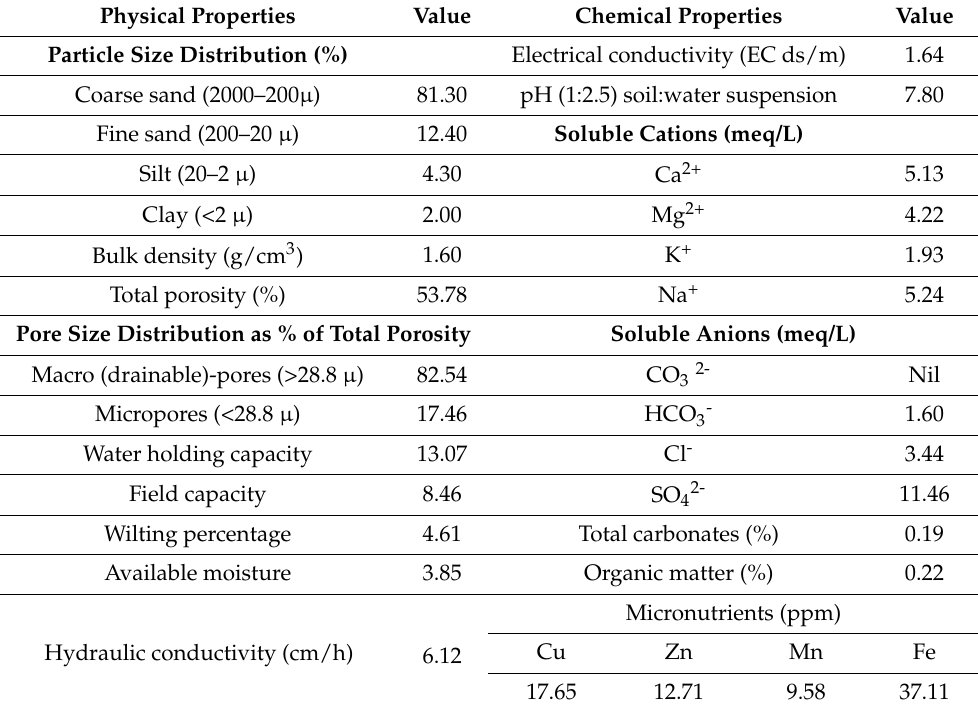
Table 3. Physical and chemical properties of experimental soil after